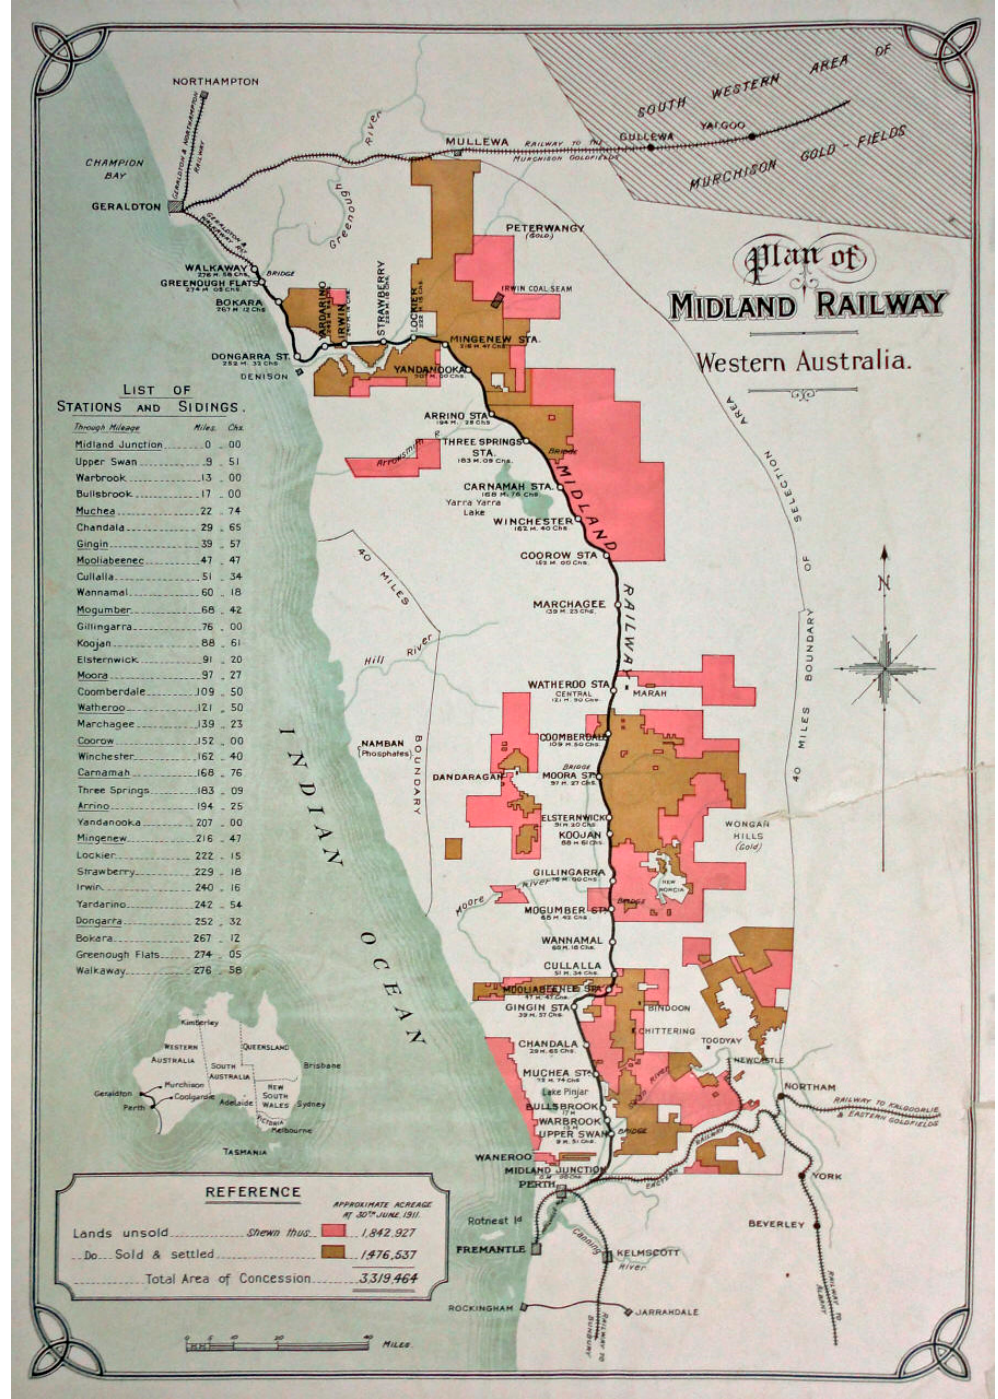
Figure 6. Map of Midland Railway, Western Australia. Source: Carnamah Historical Society.